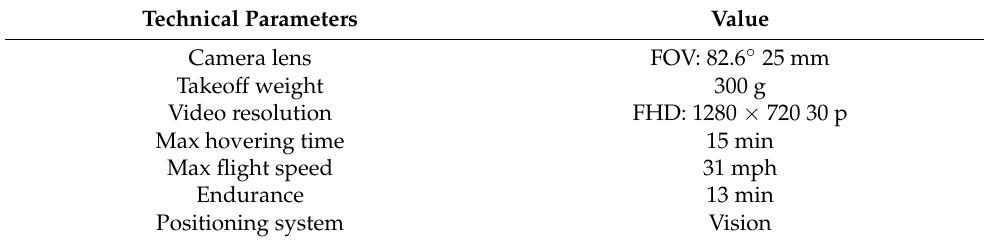
Table 1. Technical specification of the UAV.